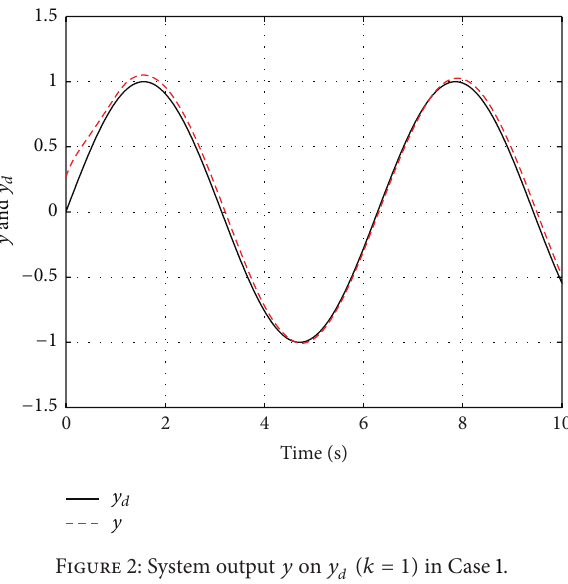
Figure 2: System output 𝑦 on 𝑦 𝑑 (𝑘 = 1) in Case 1.